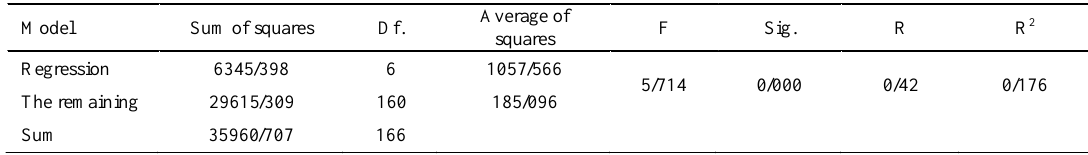
Table 4: Summary of regression model, analysis of variance and regression statistical characteristics of individual interaction and organizational commitment